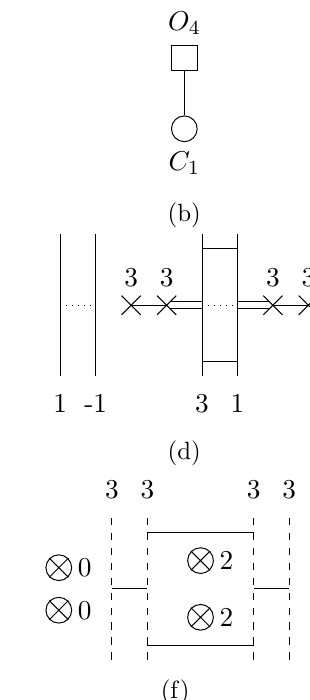
Figure 20. Orthosymplectic model with M H = (cid:22) O (cid:21) (cid:26) so (4) and (cid:21) = (2 2 ). The parameters of the model are n s = n d = 4, ~l d = (3 ; 3 ; 3 ; 3), ~l s = (1 ; (cid:0) 1 ; 3 ; 1) and rightmost orientifold